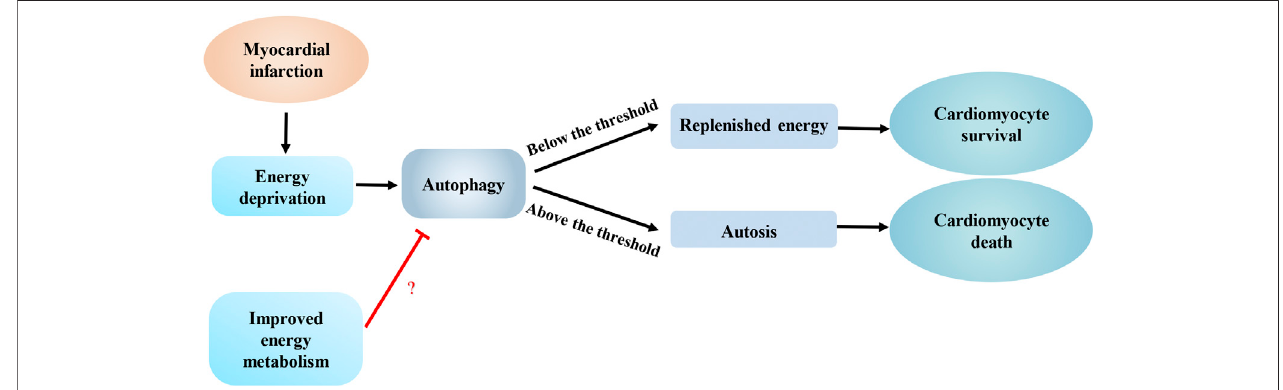
FIGURE 3 | Interaction between autophagy and energy metabolism in ischemic heart diseases. Energy deprivation caused by myocardial infarction enhances autophagy to promote cardiomyocyte survival by replenishing energy, however, excess autophagy can induce autosis, which can lead to cardiomyocyte death. An improvement in energy metabolism melay limit autophagy to an appropriate